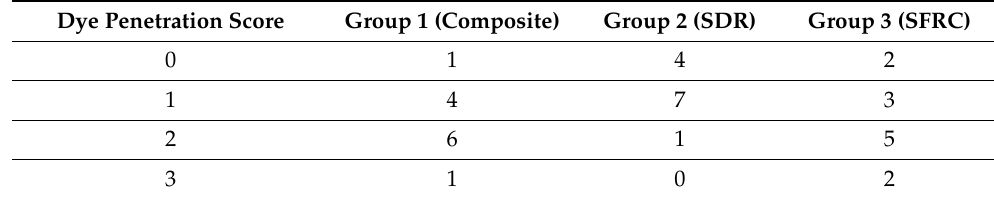
Figure 2. Column plots of fracture resistance by group (group mean +/ − SD). Table 4. The distribution of fracture patterns among the tested groups ( n = 12). Regarding the fracture pattern, cavities restored with SFRC (Group 3) managed to show the highest number (dominantly restorable), while teeth restored with SDR (Group 2) presented the lowest number (dominantly non-restorable) of repairable fractures (Table 4). Therefore, the null hypothesis regarding fracture patterns was also rejected. Table 5. The microleakage score among the tested groups ( n = 12).